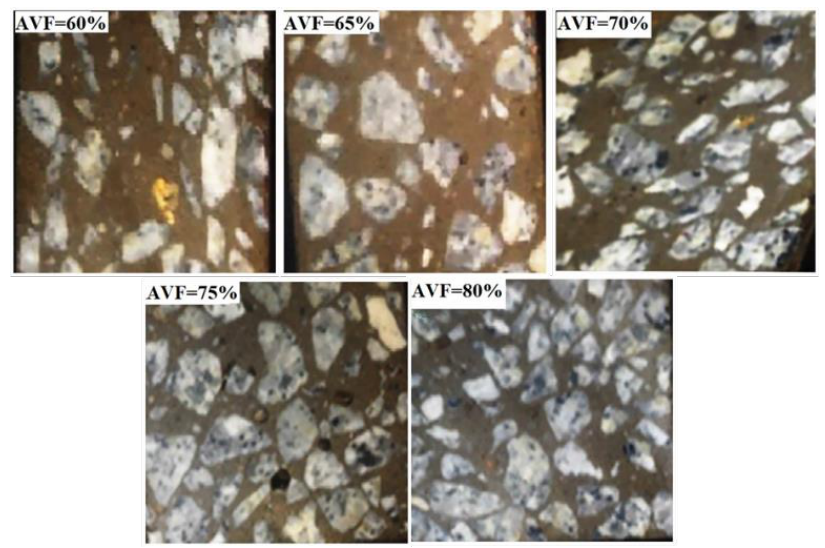
Figure 4. Cross-sections of GC2, GC5, GC13, GC1, and GC9 mixes representing an AVF of 60%, 65%, 70%, 75%, and 80%, respectively. 70%, 75%, and 80%,